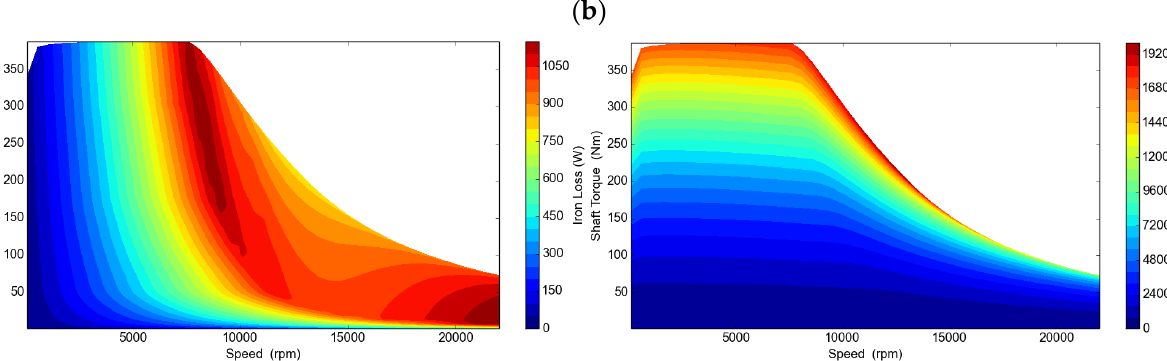
Figure 6. Maps of iron and joule stator losses for the three designs.